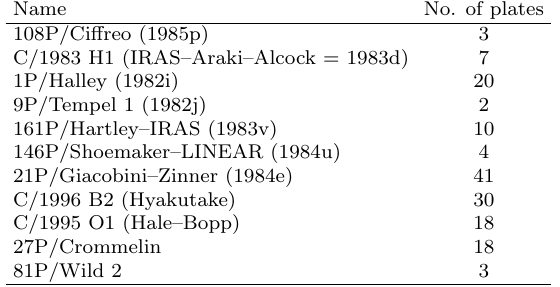
Fig. 2. Comet Hyakutake (1996 April 8). Photo by V. P. Osipenko. The tail length is 5 ◦ . Long narrow threads are the ionic tail. The wide tail consists of dust. Table 2. List of the comets of the Zvenigorod Observatory plate